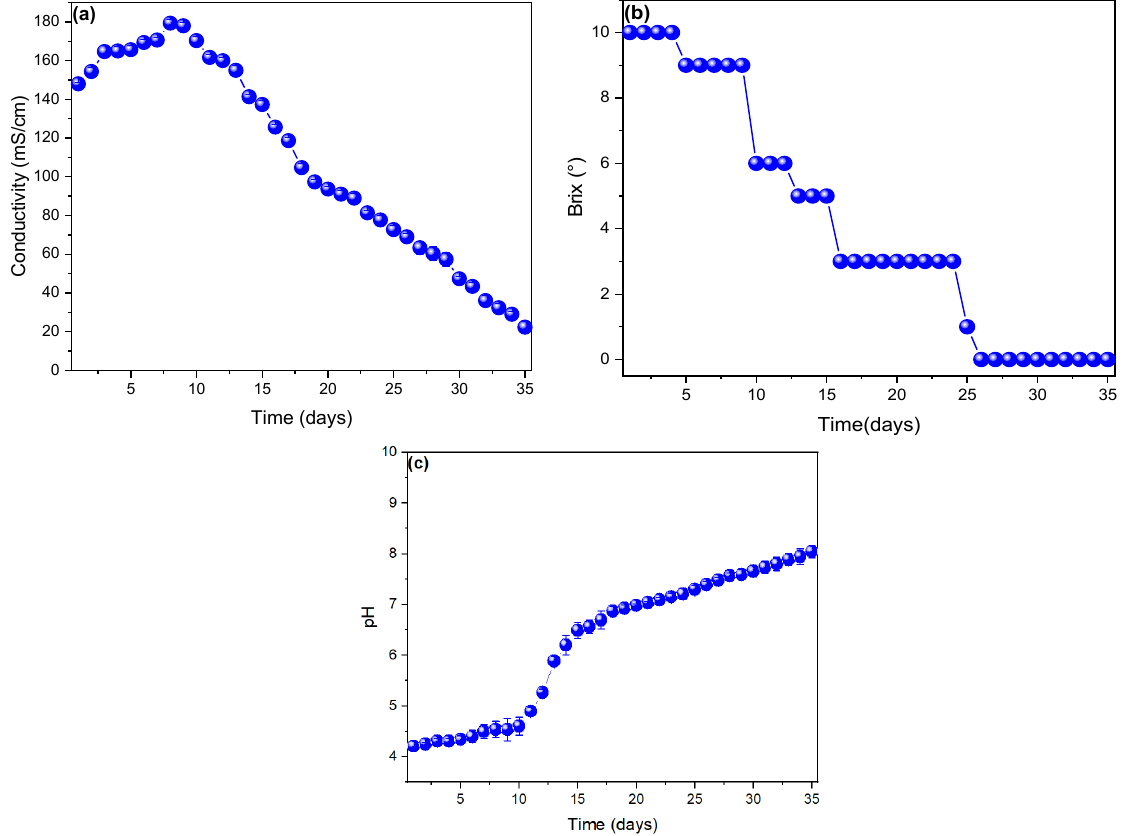
Figure 3. Values of ( a ) conductivity, ( b ) degrees Brix, and ( c ) pH of MFCs during the 35 days of monitoring.